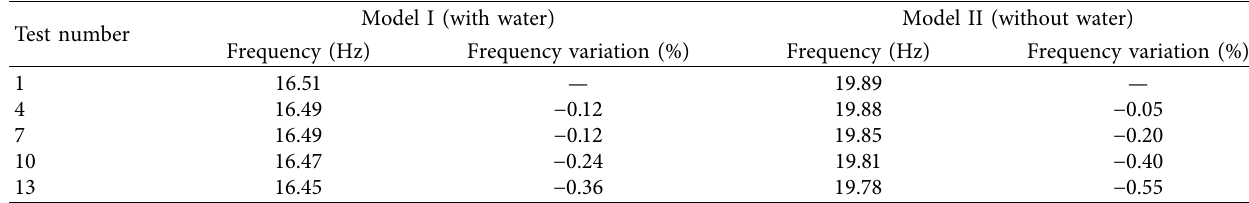
Table 5: Loading conditions of shaking table